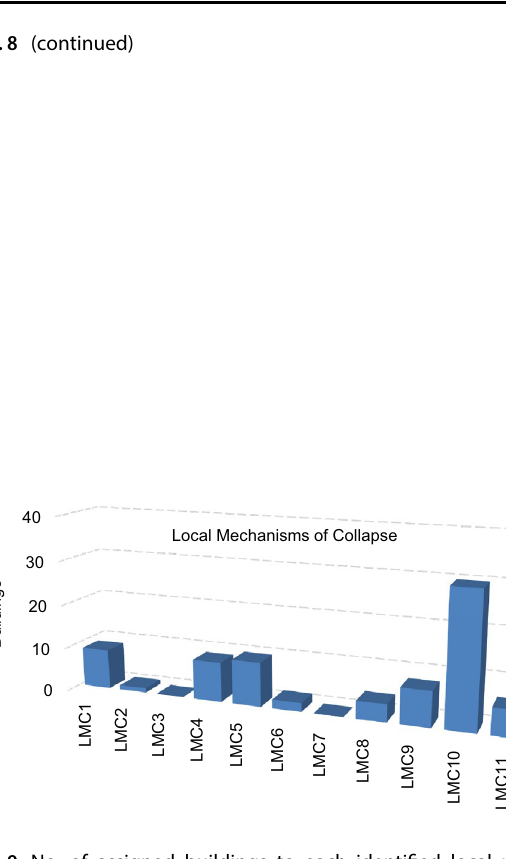
Table 6 Number of assigned Local mechanisms of collapse No. of buildings to each identified local mechanisms of collapse